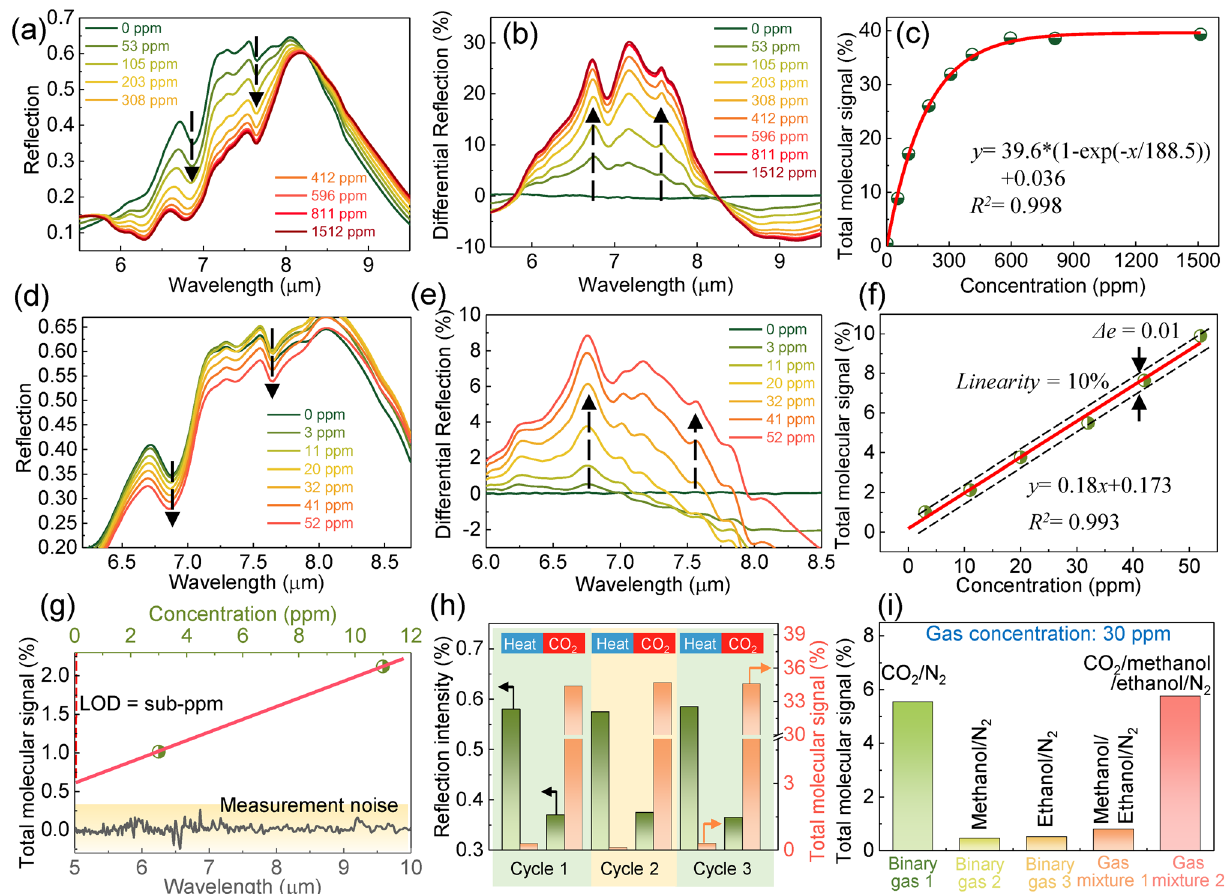
Fig. 6 Demonstration of ultrasensitive CO 2 gas detection using the MOF-functionalized multi-hotspot platform. a Measured spectral response of the hybrid platform when CO 2 concentrations vary over a wide range (0–1512 ppm). b Corresponding differential signal with the measured spectrum of 0 ppm as reference. c Total molecular signal versus CO 2 concentration profile showing the sensing behavior of the platform over a wide concentration range. d Measured spectral response of the platform in a small CO 2 concentration range (0–52 ppm). e Corresponding dif- ferential signal. f Total molecular signal versus CO 2 concentration profile in a small CO 2 concentration range. g Limit of detection (LOD) of the hybrid platform for CO 2 gas detection. h Thermal recovery and repeatability of the platform. The reflection intensity and total molecular signal change repeatedly when the platform undergoes consecutive cycling between thermal desorption and CO 2 loading. i Selectivity of the platform for CO 2 gas detection. When measuring different gas mixtures (N 2 as carrier gas), the signal response of the platform is significant in the pres- ence of